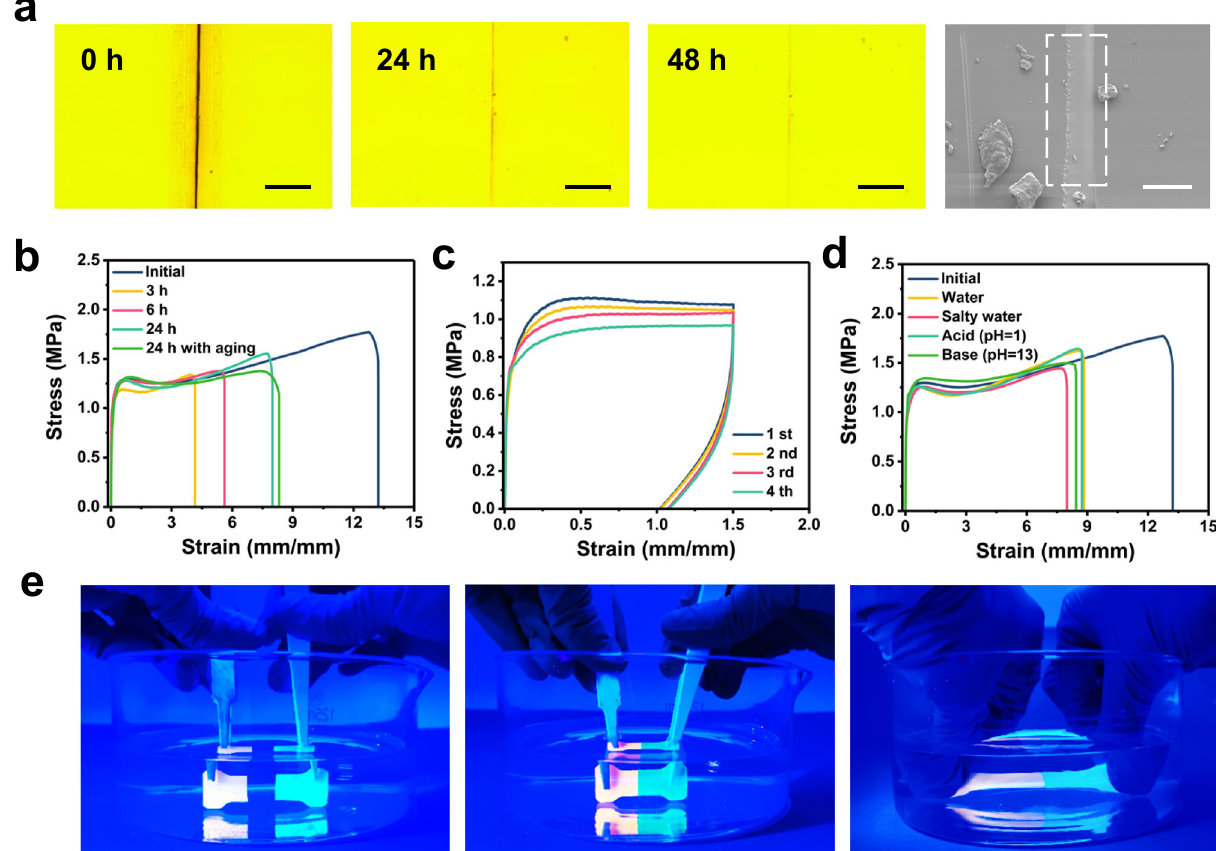
Fig. 6 Self-healing performance of TFE-HF-QD 1.0 . a Optical and SEM image of TFE-HF-QD 1.0 before and after healing. Scale bar of optical images, 200 μ m. Scale bar of SEM image, 50 μ m. b Stress – strain curve of TFE-HF-QD 1.0 after healing in air. c Stress – strain cycling curves of the cut TFE-HF-QD 1.0 samples with the interval 30 min. d Stress – strain curve of TFE-HF-QD 1.0 after healing under different aqueous conditions. e Cut samples healed underwater and stretched after